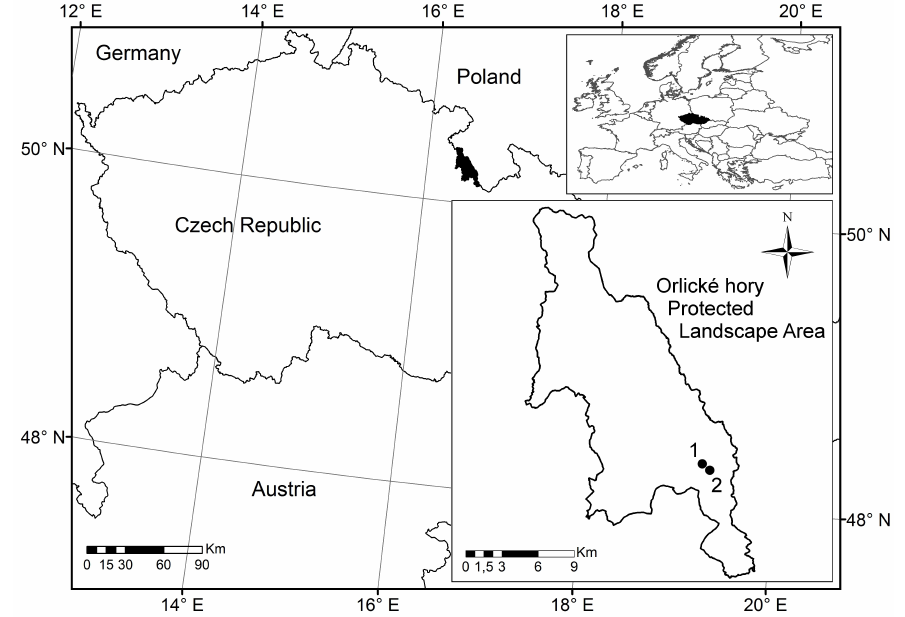
Figure 1. Location of autochthonous mixed stands on permanent research plots (PRPs) 1 and 2 in Černý důl N ature Reserve (PRP 1: 50° 12′05″ N, 16 ° 31′10″ E; PRP 2: 50° 12′03″ N, 16 ° 31′14″ E)